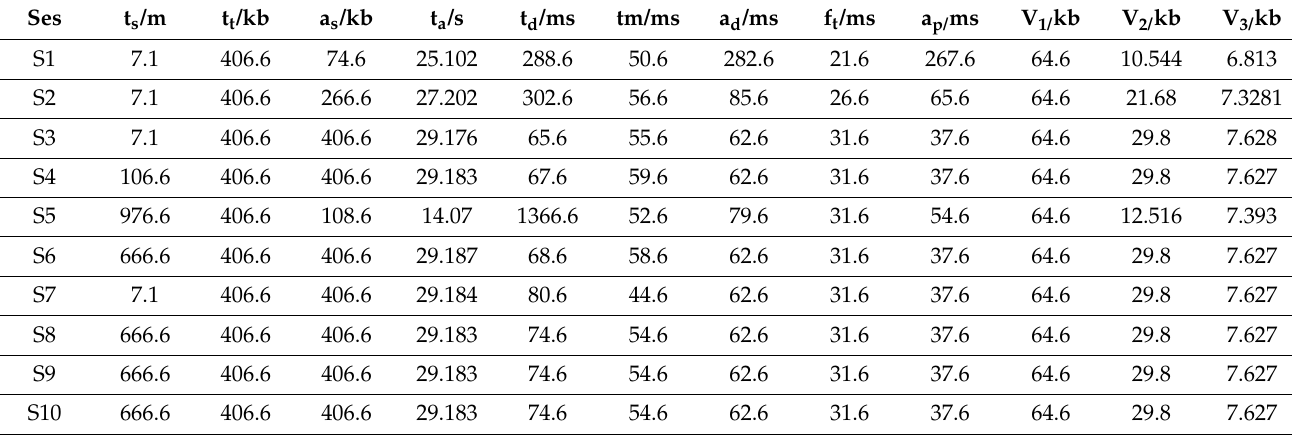
Figure 7. The verification rate of obscureness. Table 1. Transmission sessions captured